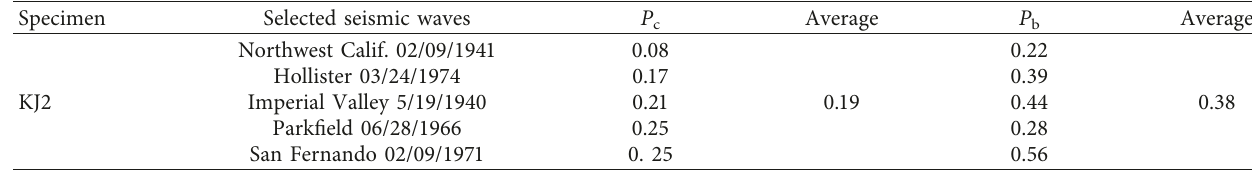
Table 7: Plastic hinge rates of beams and columns in model KJ2.